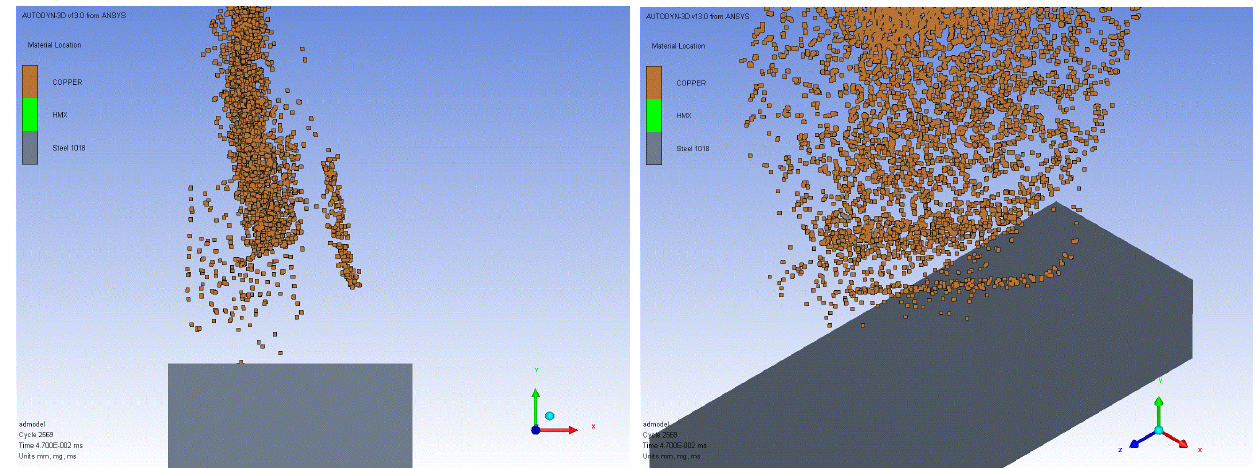
Figure 6. Front and isometric view after jet traveling 6 inches (15.24